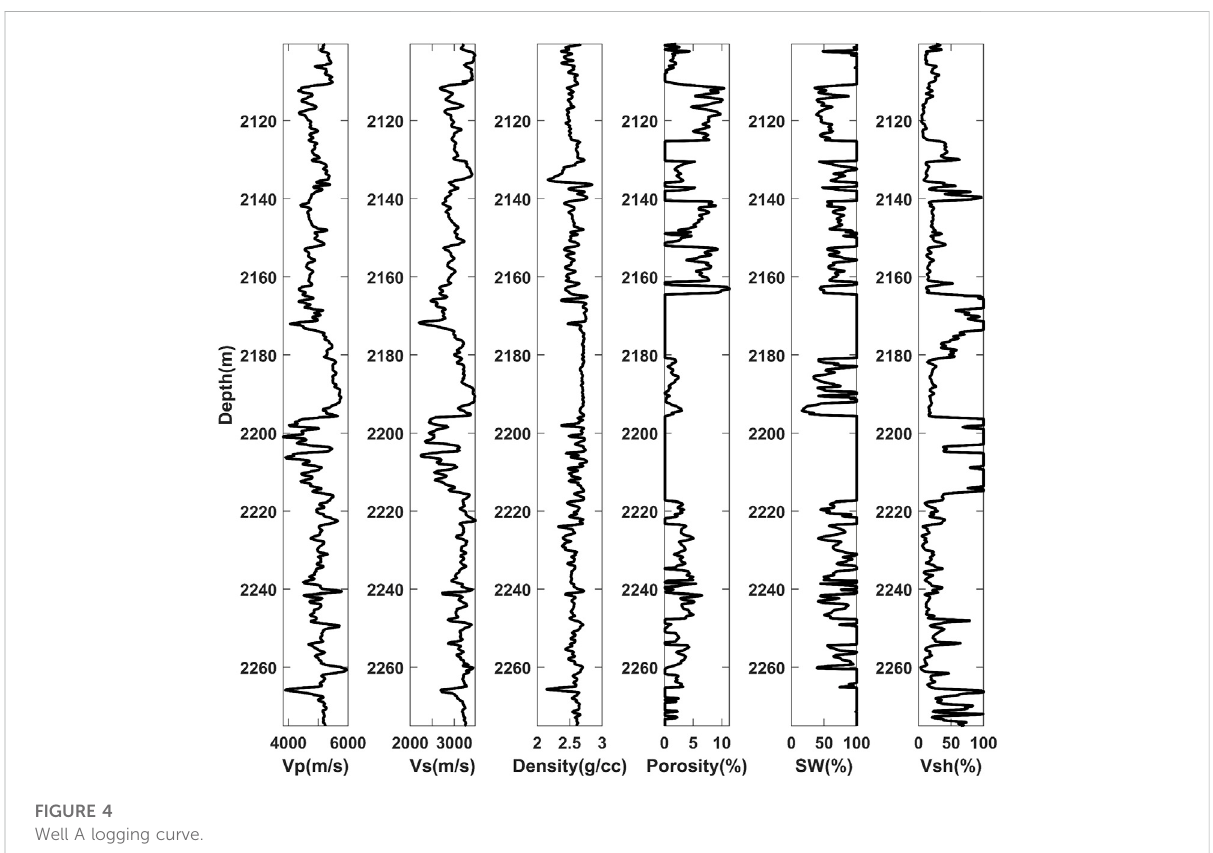
FIGURE 4 Well A logging